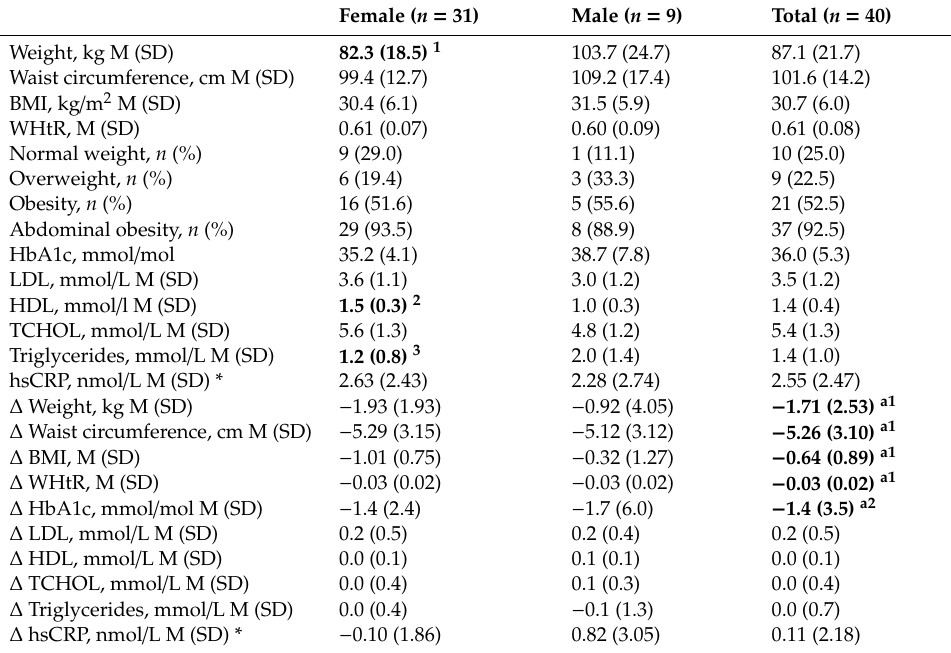
Table 3. Follow-up results of participants in the TRF-GP pilot study